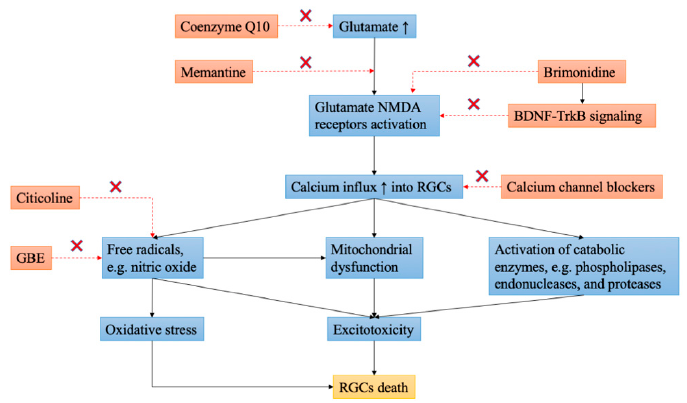
Figure 2. Schematic diagram illustrating the mechanism of glutamate excitotoxicity and summariz- ing potential therapeutic mechanisms of several agents in neuroprotection related to glutamate ex- citotoxicity. The symbol “×” indicates inhibition. BDNF, brain-derived neurotrophic factor; GBE, ginkgo biloba extract; NMDA, N-methyl-D-aspartate; RGCs, retinal ganglion cells; TrkB, tropomy- osin receptor kinase B.